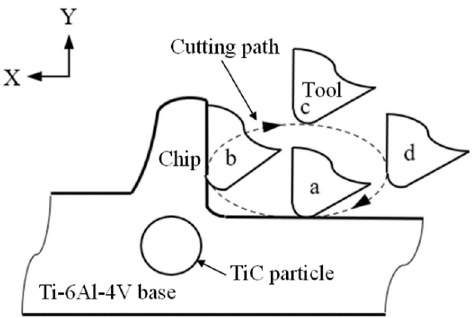
Figure 1. Schematic diagram of elliptical vibration cutting principle.